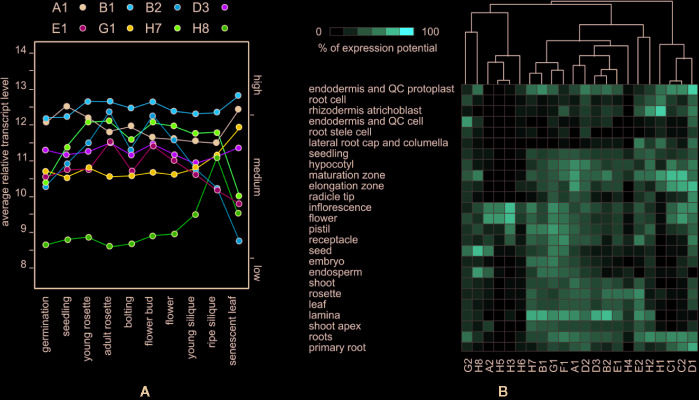

(A) Developmental distribution of expression levels of the eight EXO70 isoforms that exhibit a high transcript level at least at one developmental stage. (B) Hierarchical clustering of EXO70 isoforms according to expression levels in a selection of anatomical parts. Gene names are abbreviated (A1 = EXO70A1 etc.); for standard locus identifiers see (Cvrčková et al., 2012).